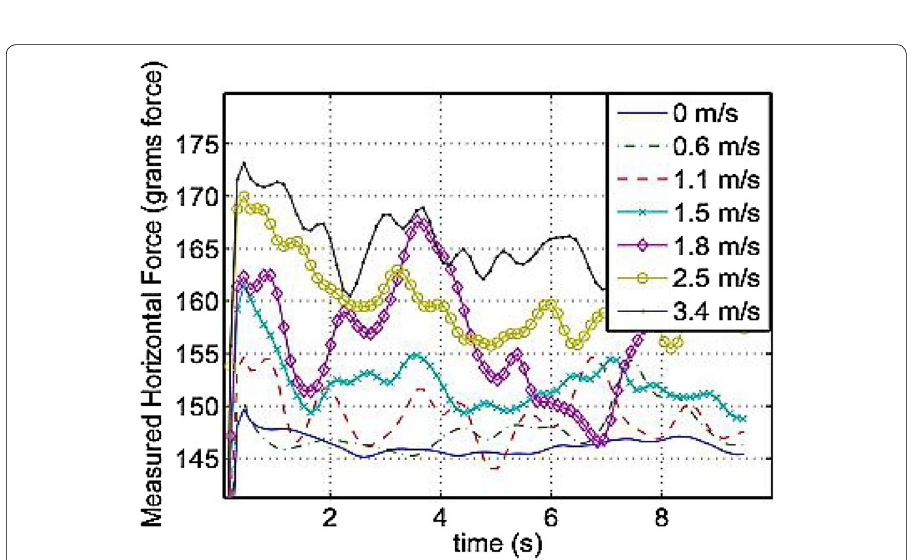
Fig. 8 Graph of the horizontal force with the increasing wind